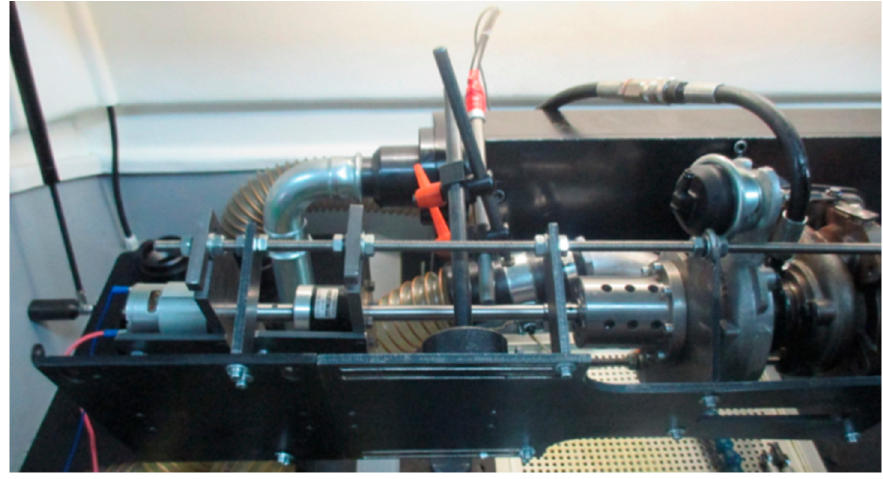
Figure 5. The hybrid turbocharger connected to compressed air of the CIMAT Turbo Test Pro.